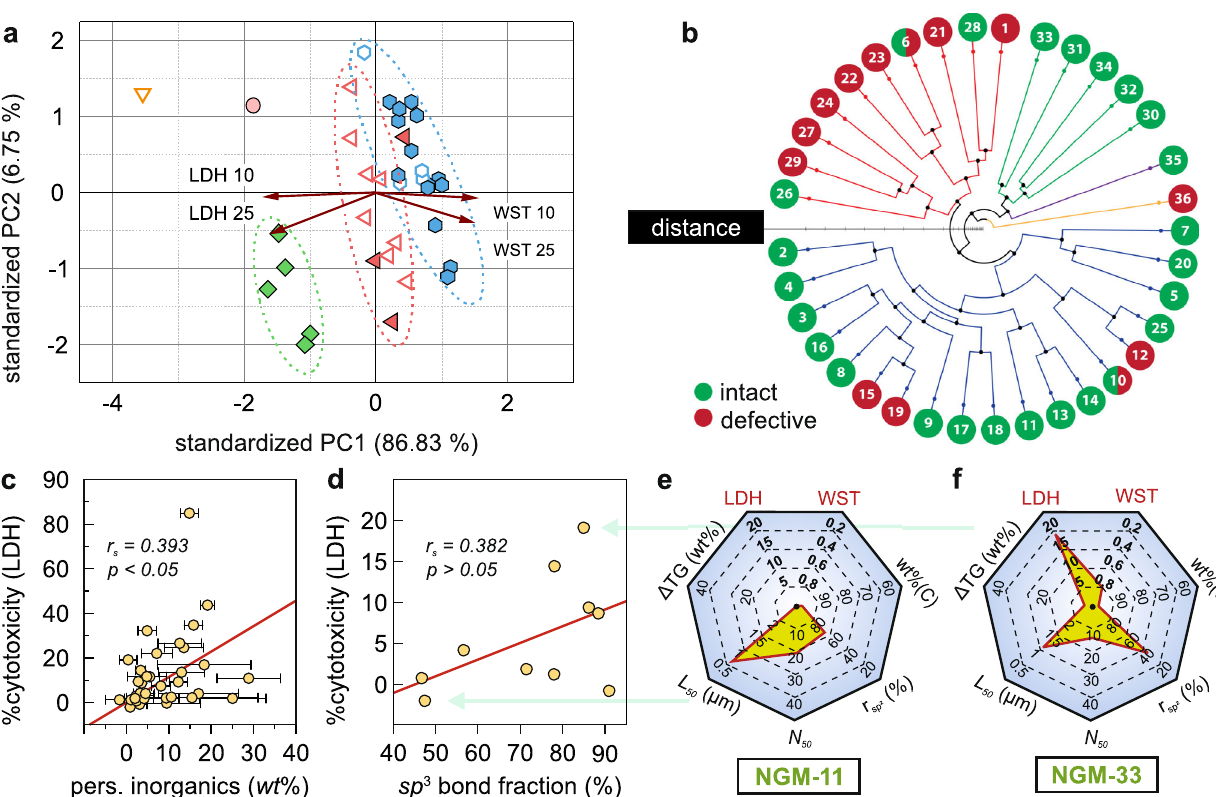
Fig. 6 Potential associations of tested properties of commercial nominal graphene materials and cell viability and membrane damage. a PCA-biplot (score and loading plot) from principal component analysis. Three apparent clusters can be seen from the PC scores of the samples. The solid scatter points are NGM int and open scatter points are NGM def . b HCA dendrogram. Vertical lines represent roots samples while horizontal lines represent similarities between samples. Two samples cannot be classi fi ed into either intact or defective graphene and are thus indicated with green/red circles. c Persistent inorganics; and d Fraction of sp 3 bonded carbon r ( sp 3 ), as a proxy measure for the surface adsorbents in the samples, plotted against the cytotoxicity. The analysis was performed for a subset of NGMs with the most graphene-like properties. e + f Performance heptagrams representing the NGMs with the lowest and highest cytotoxic pro fi le in d . The red line represents the linear fi t ( c and d ). Deviation bars represent the upper and lower bound for